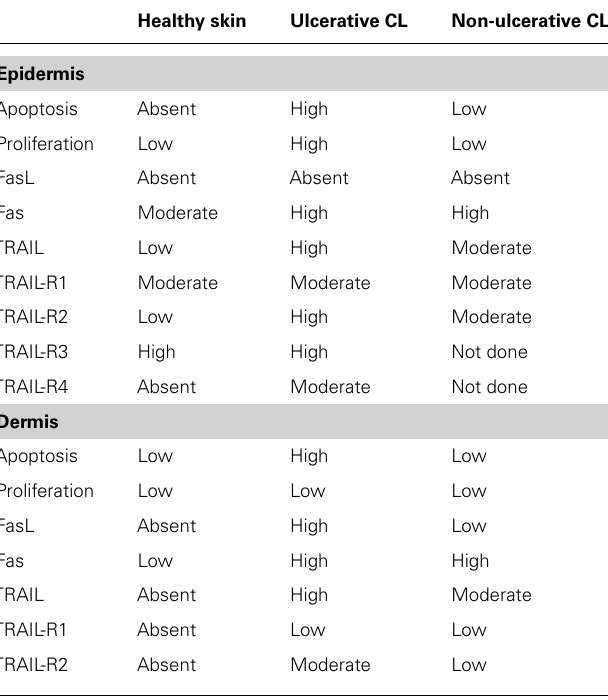
Table 1 | Increased expression of FasL,TRAIL,TRAIL-R2, and -R4 at the site of infection during ulcerative leishmaniasis. Healthy skin Ulcerative CL Non-ulcerative